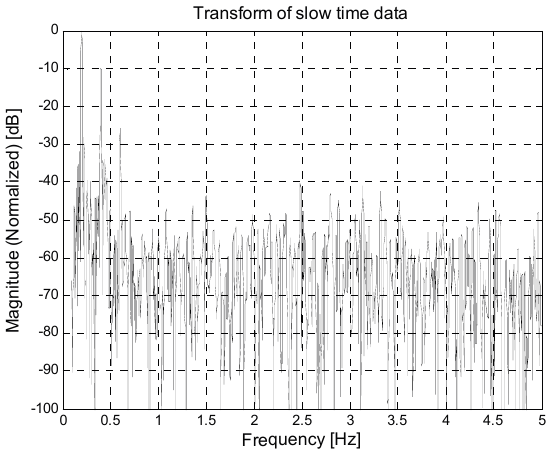
Figure 25. 3-D representation of matrix R in the presence of external EMI sources. ( a ) Before motion filtering; ( b ) After motion filtering.